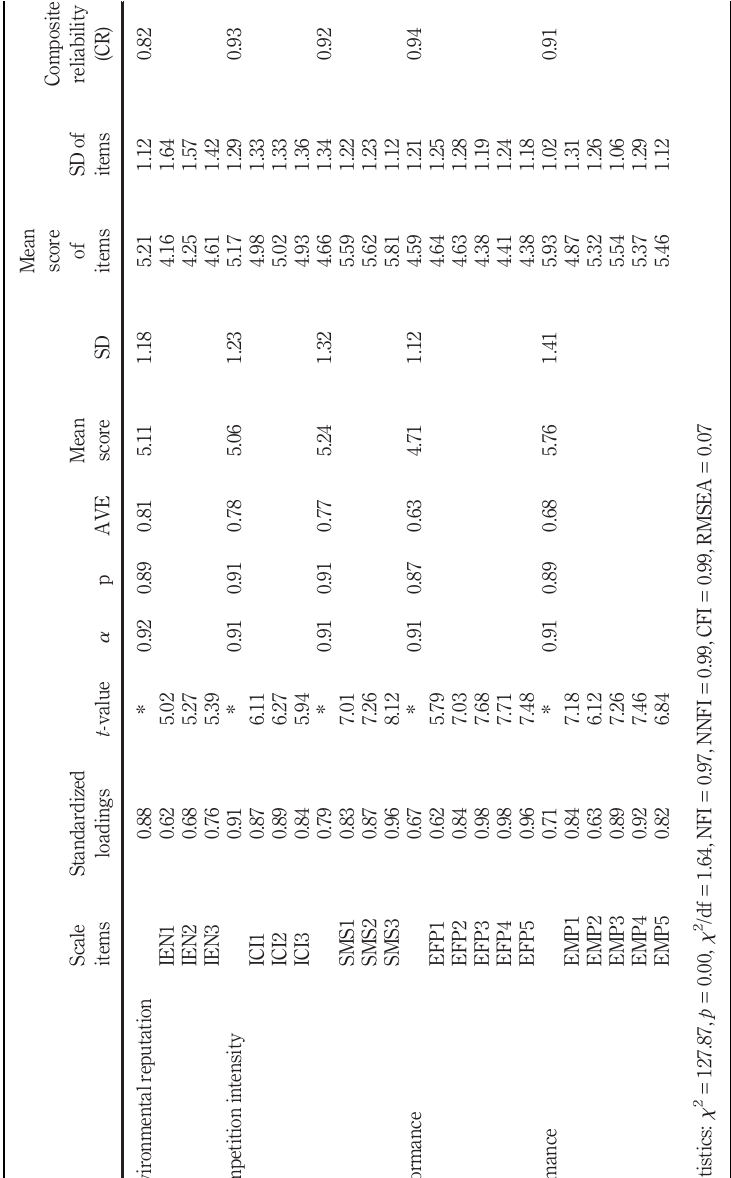
Table IV. Measurement models and summary